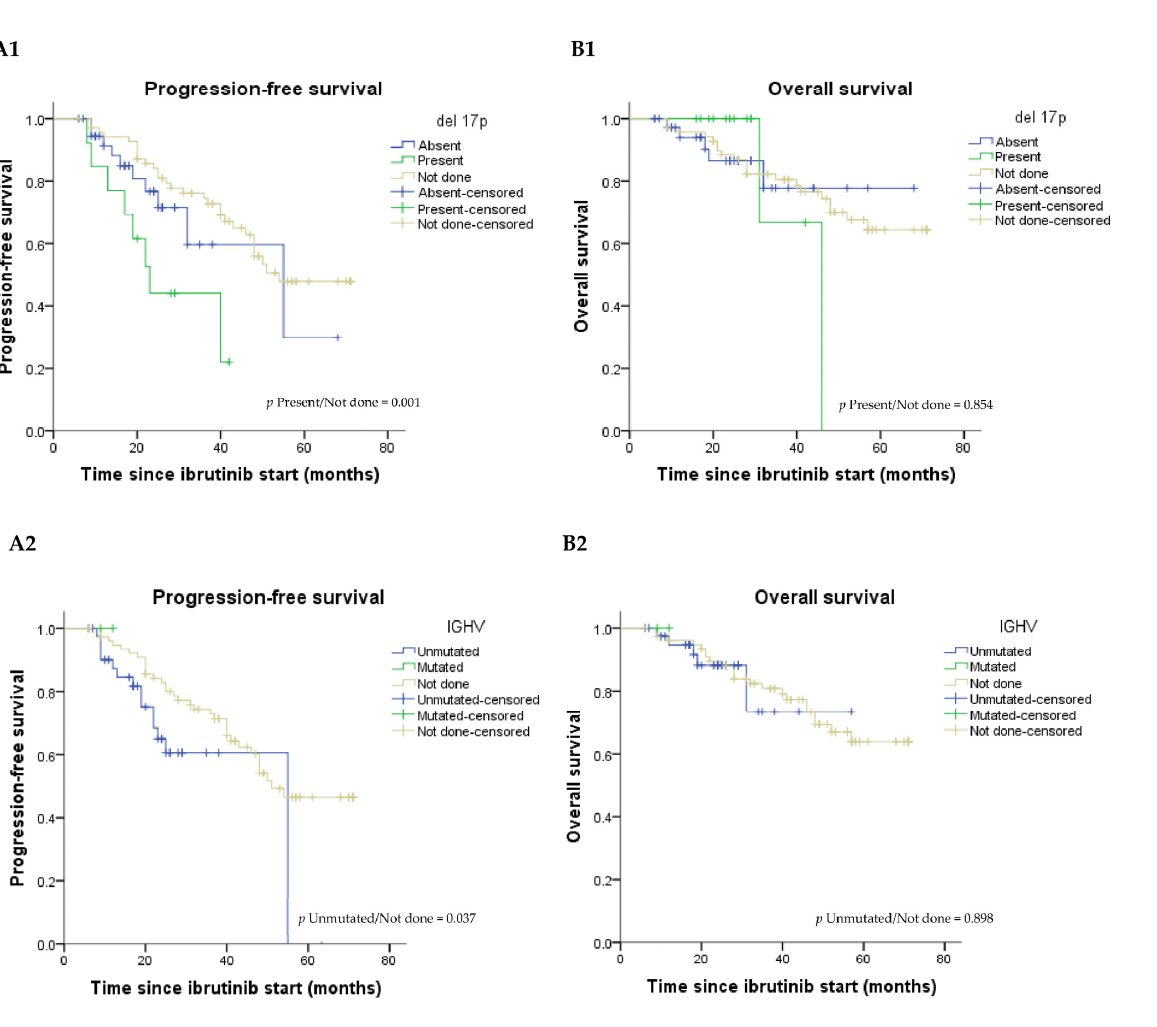
Figure 1. Kaplan–Meier estimated progression-free survival and overall survival curves according to the del 17p (( A1 ) and ( B1 ), respectively) and IGHV status (( A2 ) and ( B2 ), respectively). Abbreviations: del 17p, deletion 17p; IGHV, immunoglobulin heavy chain variable region genes. The log-rank tests showed that PFS and OS were not different in patients with other high-risk features, such as the unmutated IGHV (Figure 1(A2,B2) and TP53 mutations (Figure S2A,B)). After the inclusion of patients with unavailable molecular data, the PFS became significantly different between those with unmutated IGHV and those with un- known status ( p = 0.037) (Figure 1(A2)).